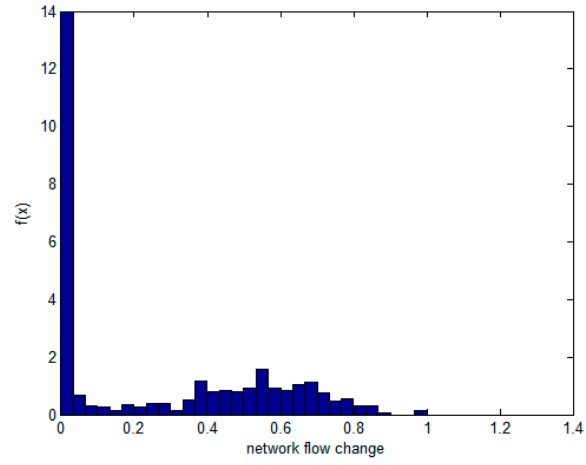
Figure 5. Frequency histogram of flow.